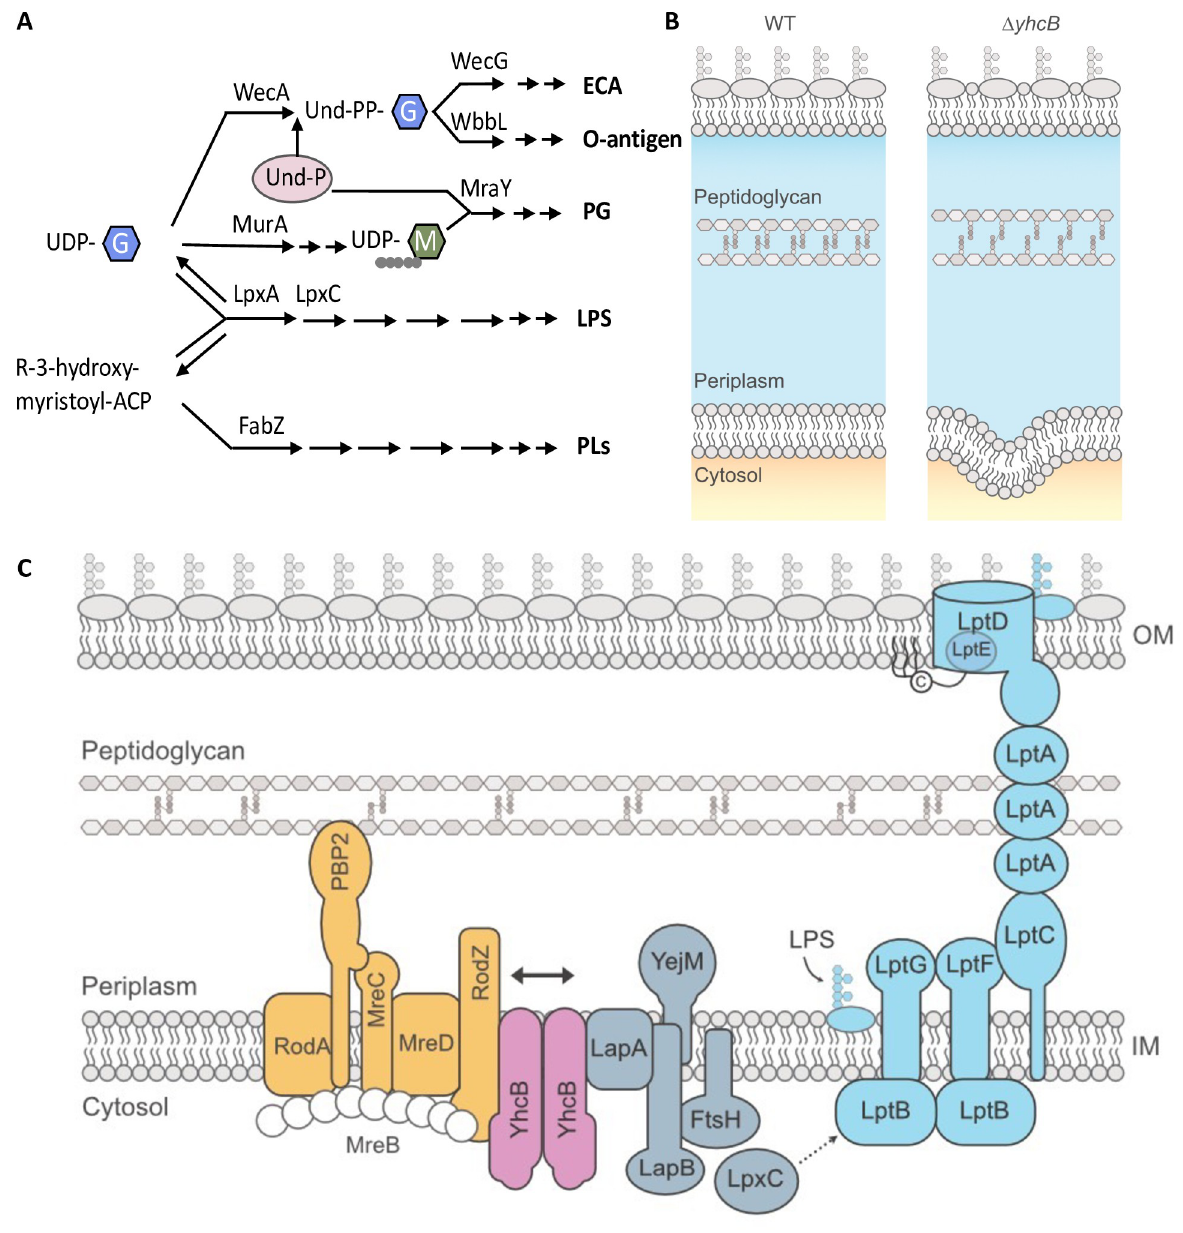
Fig 11. The pathways of cell envelope biosynthesis and relationship with YhcB. (A) Schematic overview of the relationships between the biosynthetic pathways of individual components of the cell envelope. (B) A schematic of the imbalanced cell envelope of a yhcB mutant in comparison to wild-type (WT). The yhcB mutant suffers from defects in OM asymmetry, excessive phospholipid synthesis and altered crosslinking in the peptidoglycan layer. (C) The positional context of YhcB in conjunction with the reported protein interaction partners of YhcB in situ . YhcB interacts with both the elongasome (amber; depicted here as mediated via RodZ, but YhcB is reported to interact with RodA, MreD and MreC in addition to RodZ) and LapA from the complex that regulates LpxC degradation (grey). YhcB is spatially positioned to coordinate peptidoglycan expansion with LPS export, represented by the solid black double arrow. For simplicity, the LPS biosynthesis pathway has been replaced by a dashed arrow from LpxC, which exacts the first committed step of LPS synthesis, to the Lpt bridge, which facilitates LPS export. Abbreviations: Enterobacterial Common Antigen (ECA); Lipopolysaccharide (LPS); Peptidoglycan (PG); Phospholipid (PL); Undecaprenyl phosphate (Und-P); Undecaprenyl diphosphate (Und-PP); Uridine diphosphate (UDP); N-acetylglucosamine (G); N-acetylmuramic acid (M); Acyl Carrier Protein (ACP). Interaction of YhcB with RodZ and LapA has been reported by Li et al . [37] and Hu et al . [116].